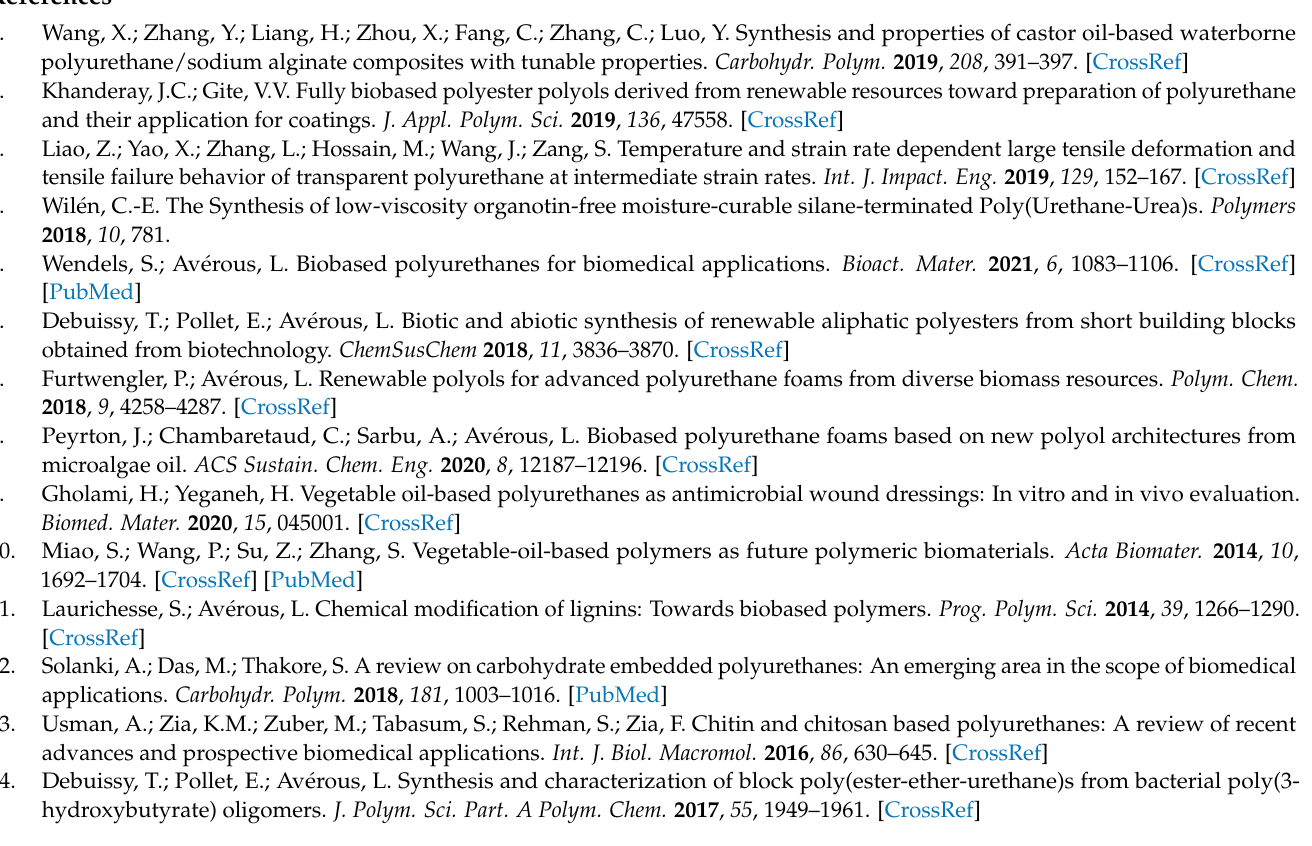
Figure SI.2: Xerogels DSC thermograms. Figure SI.3: Pictures of the degraded xerogels after 12 weeks incubation without magnification (samples diameter = 1 cm) and zoomed observations